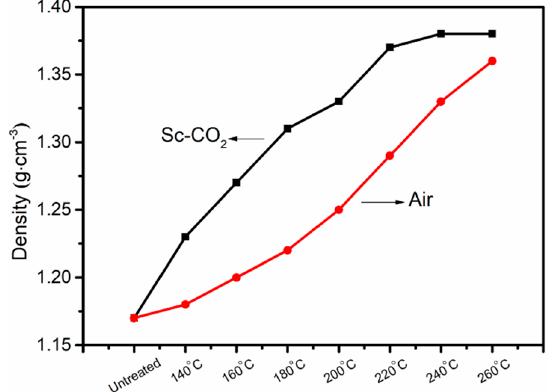
Figure 12. The density changes of PAN fibers.